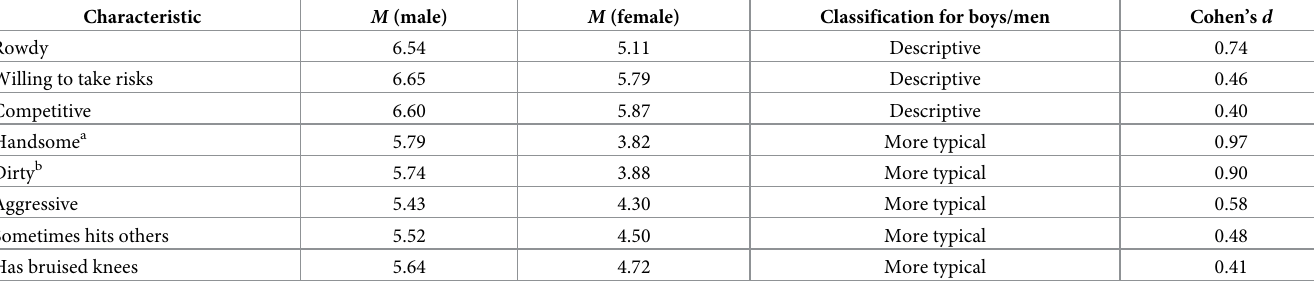
Table 3. Characteristics rated as consistently more typical in boys/men than girls/women across the lifespan. Characteristic